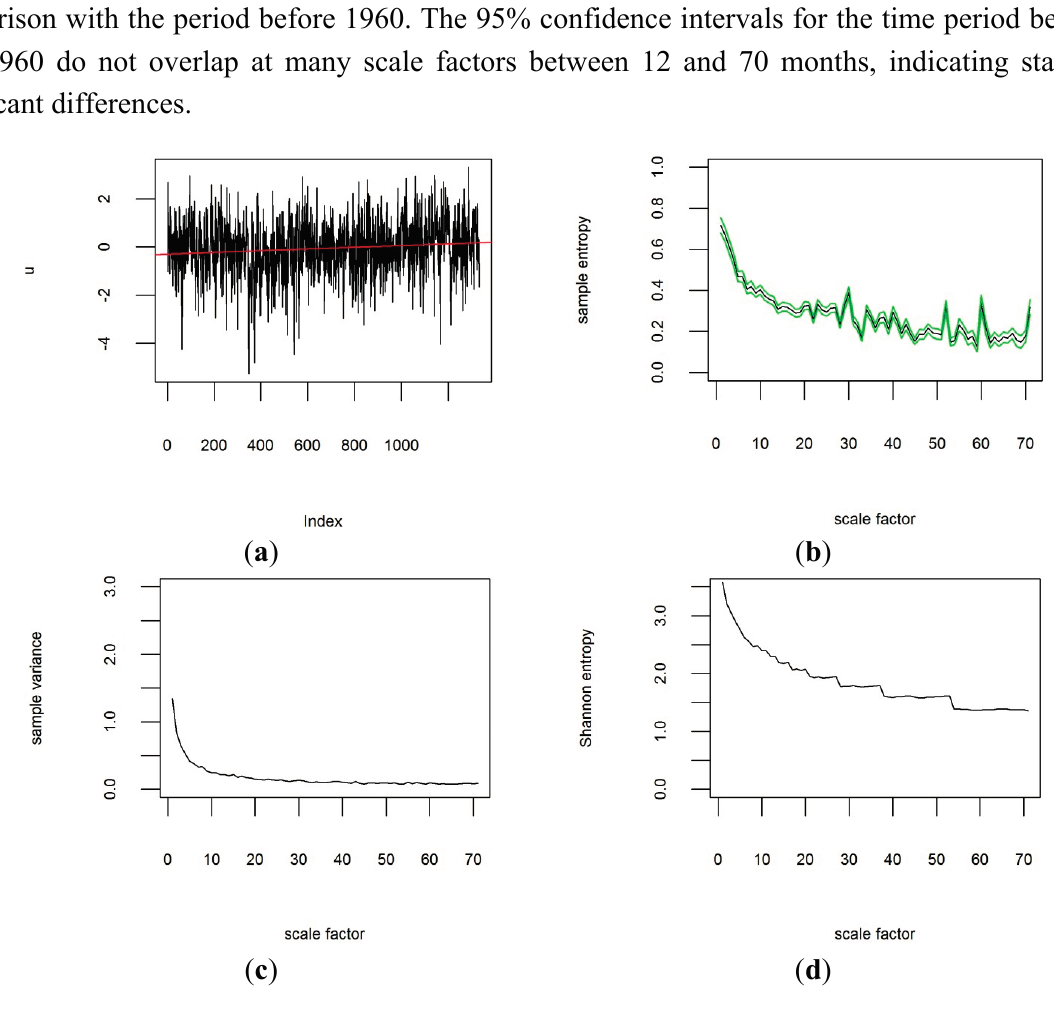
Figure 3. Time-series from 1851–1960 of CRUTEM4v variance-adjusted surface temperature anomaly data for grid box [8|35] centred on 52.5° latitude and − 7.5° longitude, with m = 3 and r = 0.3. Scale factor is shown in months. ( a ) original time-series; ( b ) multi-scale sample entropy for the grid box (95% confidence intervals in green) against scale factor; ( c ) sample variance for different scale factors; ( d ) Shannon information theoretic entropy for different scale